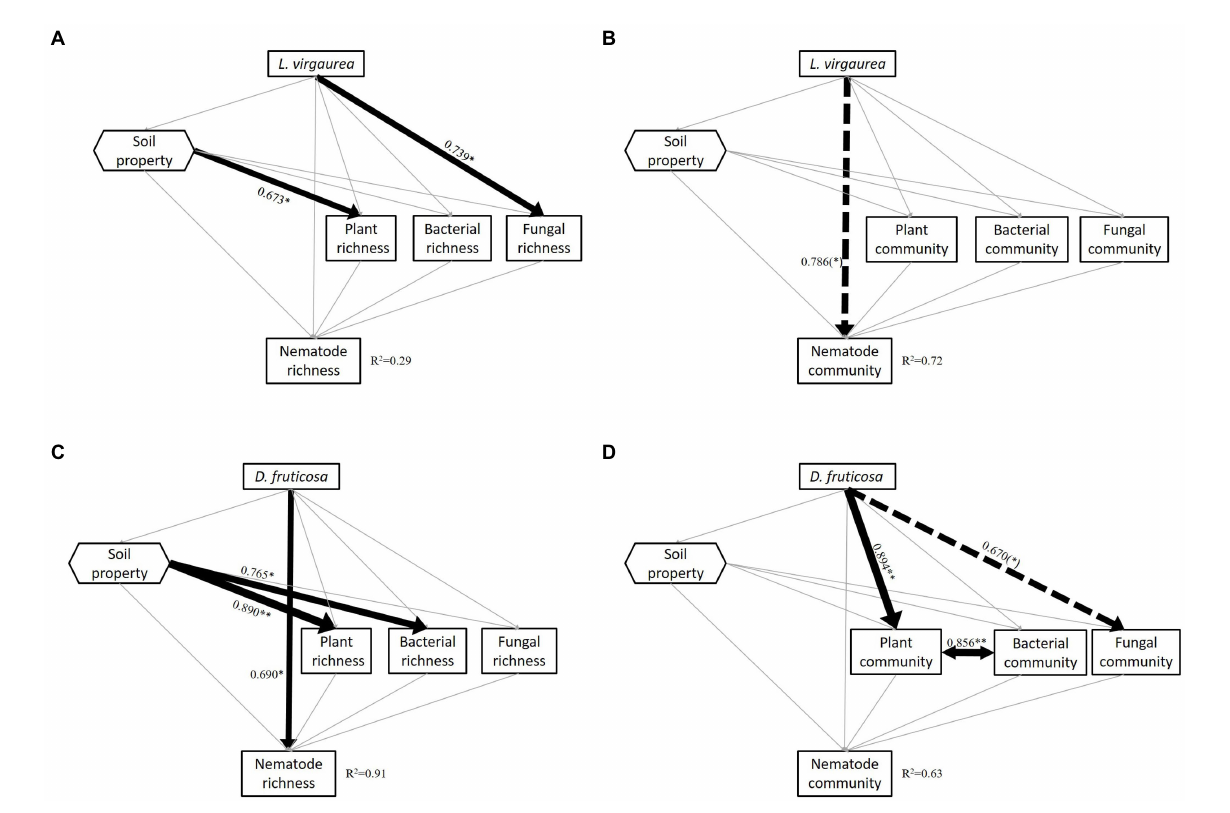
FIGURE 3 Results of the piecewise SEM analyses indicating direct and indirect effects of L. virgaurea on nematode (A) richness (Fisher’s C = 8.013, p = 0.237, AIC = 52.013, df = 6) and (B) community composition (Fisher’s C = 2.632, p = 0.621, AIC = 46.632, df = 4) and D. fruticosa on nematode (C) richness (Fisher’s C = 5.699, p = 0.458, AIC = 49.699, df = 6) and (D) community composition (PC1) (Fisher’s C = 3.115, p = 0.794, AIC = 47.115, df = 6). Square boxes display variables included in the model: Plant richness, understory plant richness; Plant community, understory plant community composition (PC1); Bacteria community, bacterial community composition (PC1); Fungi community, fungal community composition (PC1); Nematode community, nematode community composition (PC1). Black line means positive correlation and red line means negative correlation; grey line mean no significant correlation. Solid arrows indicate significant effects ( p < 0.05), and dashed arrows indicate marginally significant effects ( p < 0.1). Arrow width corresponds directly to the standardized path coefficient. R 2 values associated with response variables indicate the proportion of explained variation by relationships with other variables. Values associated with solid arrows and dashed arrows represent standardized path